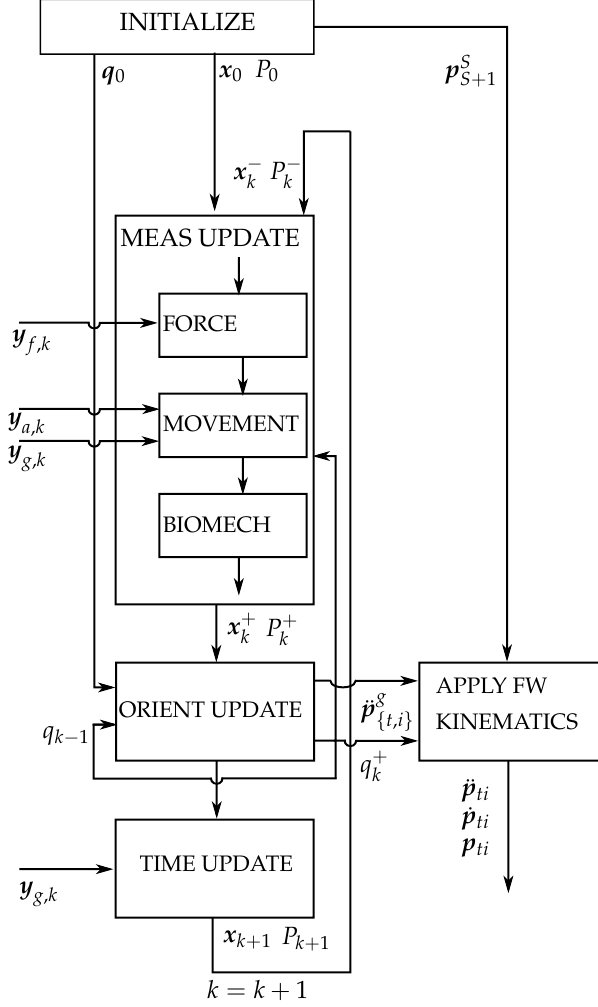
Figure 4. Topology of the kinematic estimation filter embodied in a extended Kalman filter (EKF) that operates on the error states (also knowns a multiplicative extended Kalman filter (MEKF) [26]). The inputs consist of the sensor data ( y f , y a , y g ) and the lengths of the finger and thumb segments ( p S ). The output consists of the relative kinematics ( ¨ p ti , ˙ p ti , p ti ) and inertial acceleration of the tips S + 1 ( ¨ p g ). After initialization of both the state ( x ), error state ( δ x ) and corresponding covariances ( P ), t , i { } a measurement update of error states according to the measured forces, accelerations, angular velocities ( y f , y a , y g ) and biomechanical dimensionality information is performed. Information of the force and movement updates can be found in Section 2.2 and Equations (13) and (14). Information of applying biomechanical constraints as a measurement update can be found in our previous article